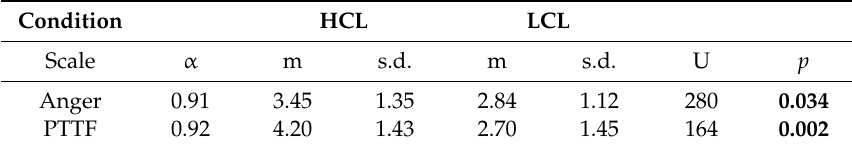
Table 3. Descriptive statistics of both reactance scales and results of a one-tailed Mann–Whitney U test comparing the two conditions (high controlling language (HCL) > low controlling language (LCL)).